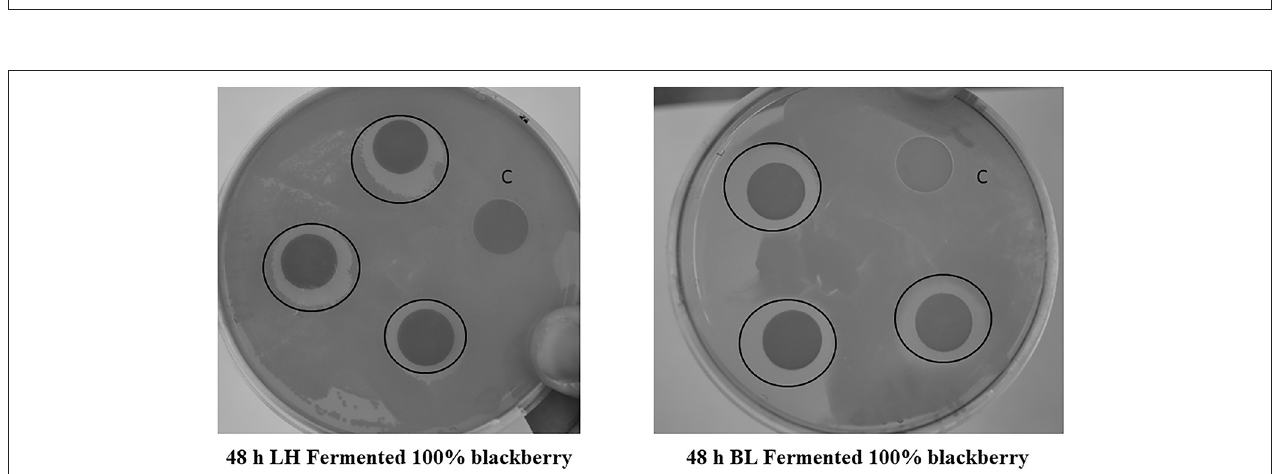
FIGURE 4 | Disc diffusion assay-based Helicobacter pyl ori inhibition observed with 48h LAB fermented ( Lactobacillus helveticus and Bifidobacterium longum ) Kiowa blackberry extracts (100%).